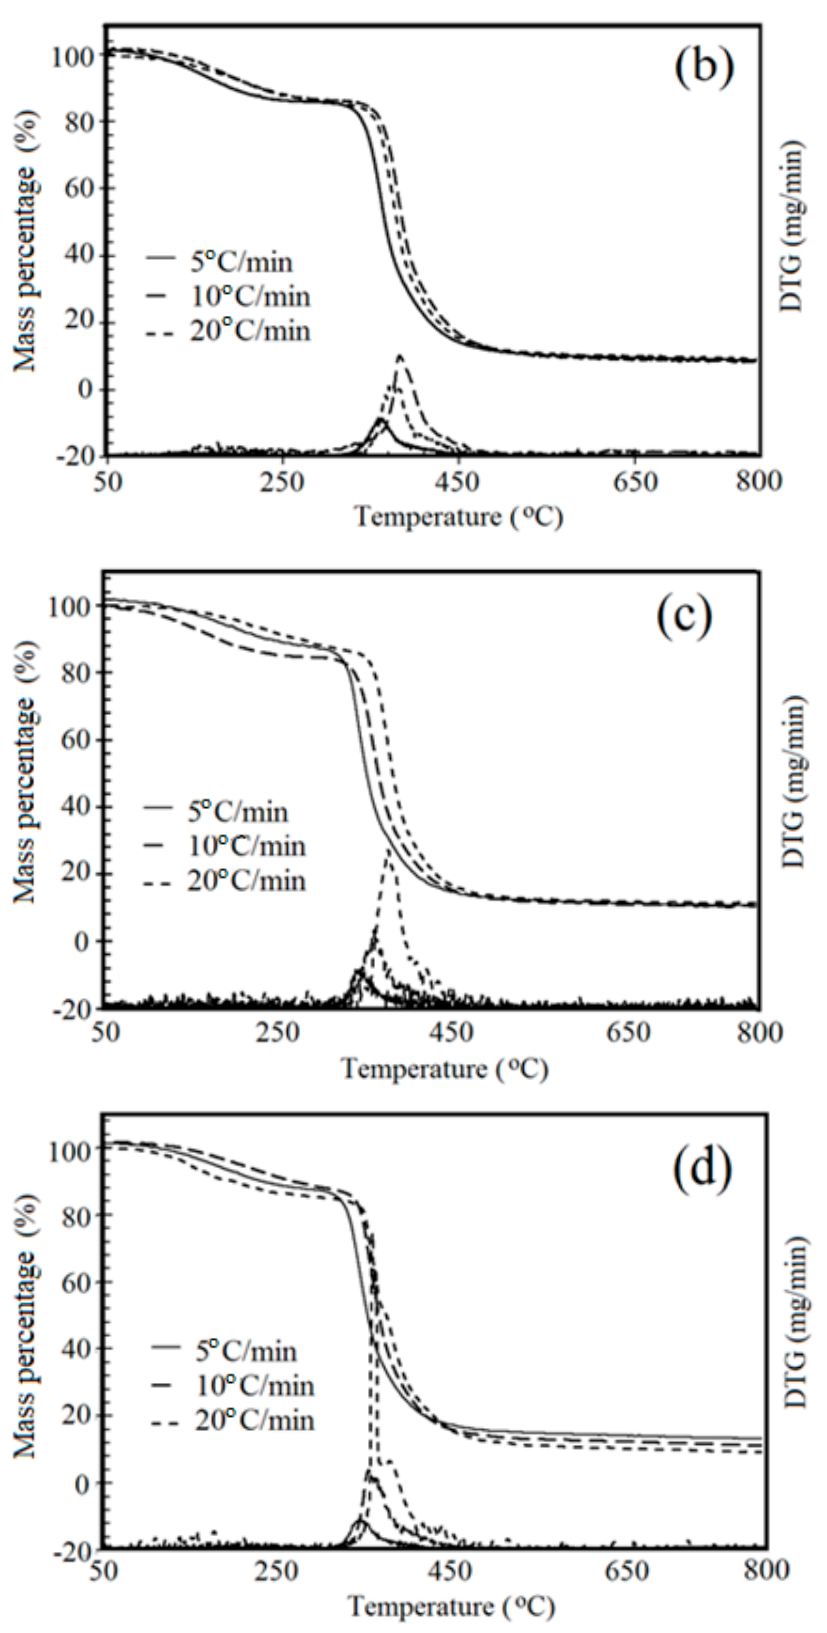
Figure 2. Variation of mass residue versus temperature at different heating rates of epoxy composites with ( a ) no filler, ( b ) 1% MWCNT/alumina, ( c ) 3% MWCNT/alumina, and ( d ) 5% MWCNT/alumina.